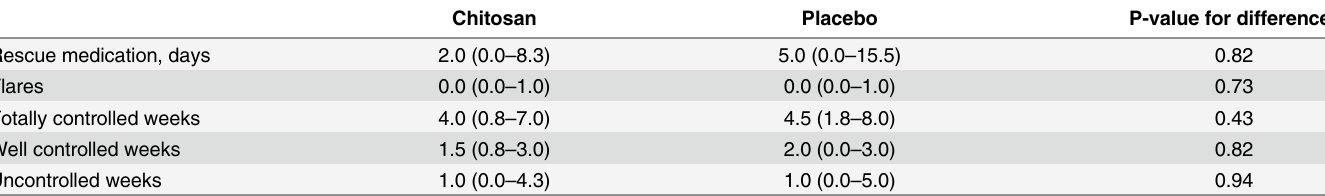
Table 2. Differences in efficacy outcomes in chitosan and placebo groups after intervention.